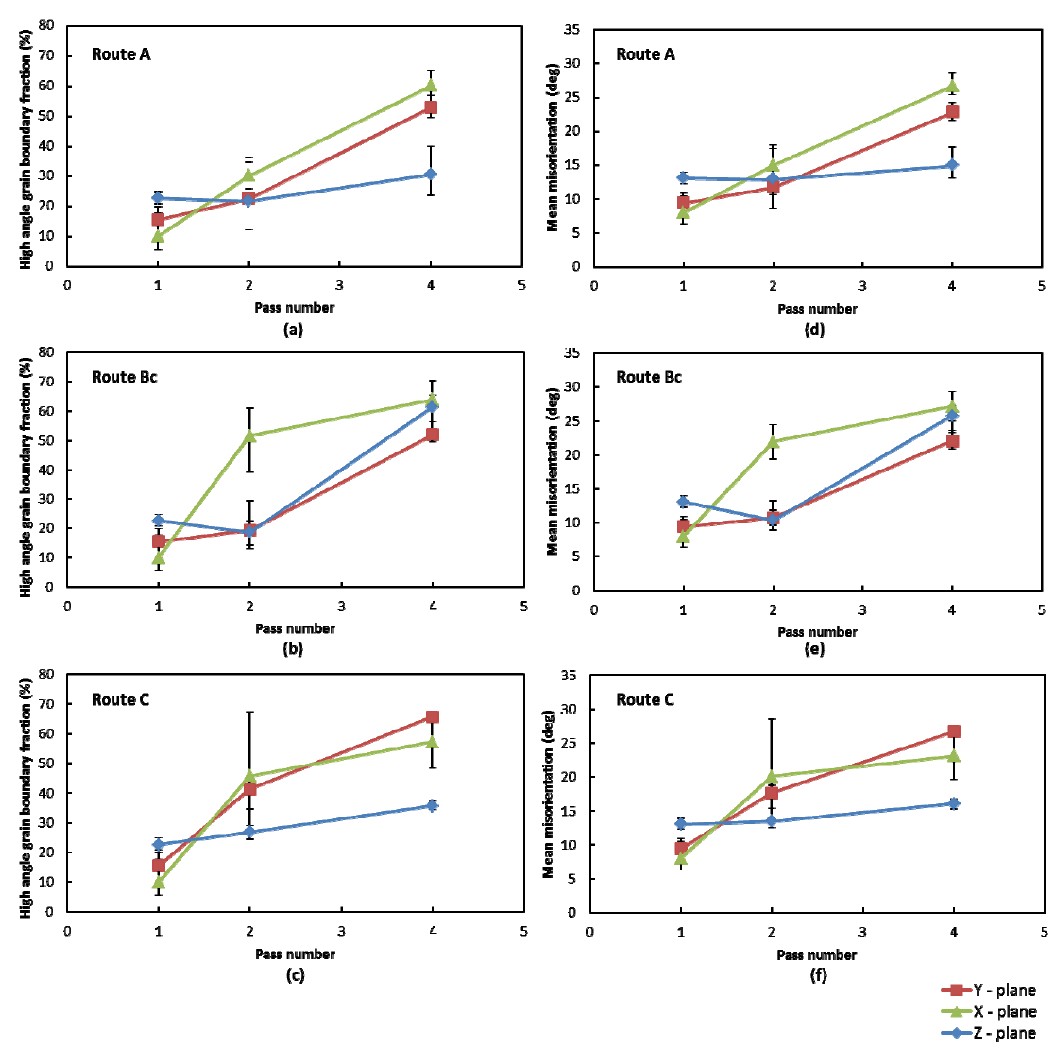
Figure 3. High angle grain boundary fraction of ECAP processed with respect to three orthogonal planes for ( a ) route A; ( b ) route Bc and ( c ) route C; and mean misorientation angle for ( d ) route A; ( e ) route Bc and ( f ) route